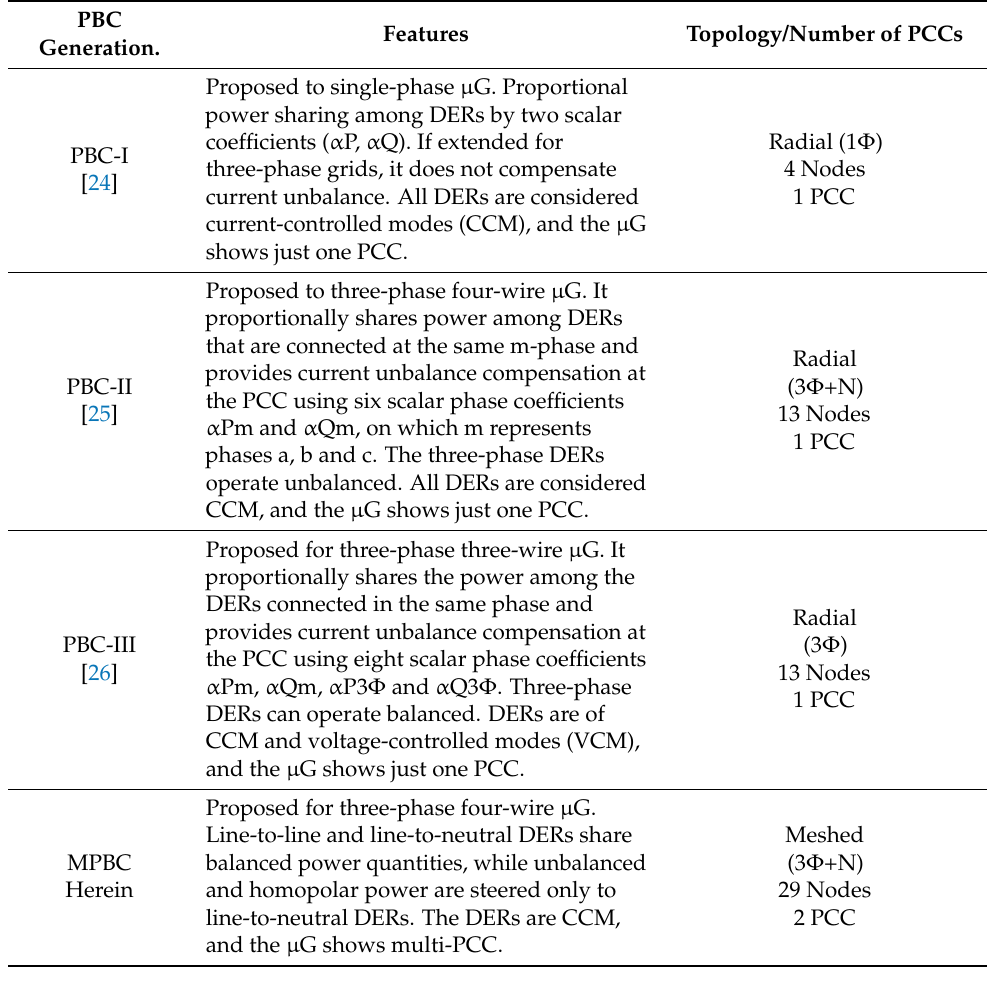
Table 1. Evolution of power-based control strategy for µ G